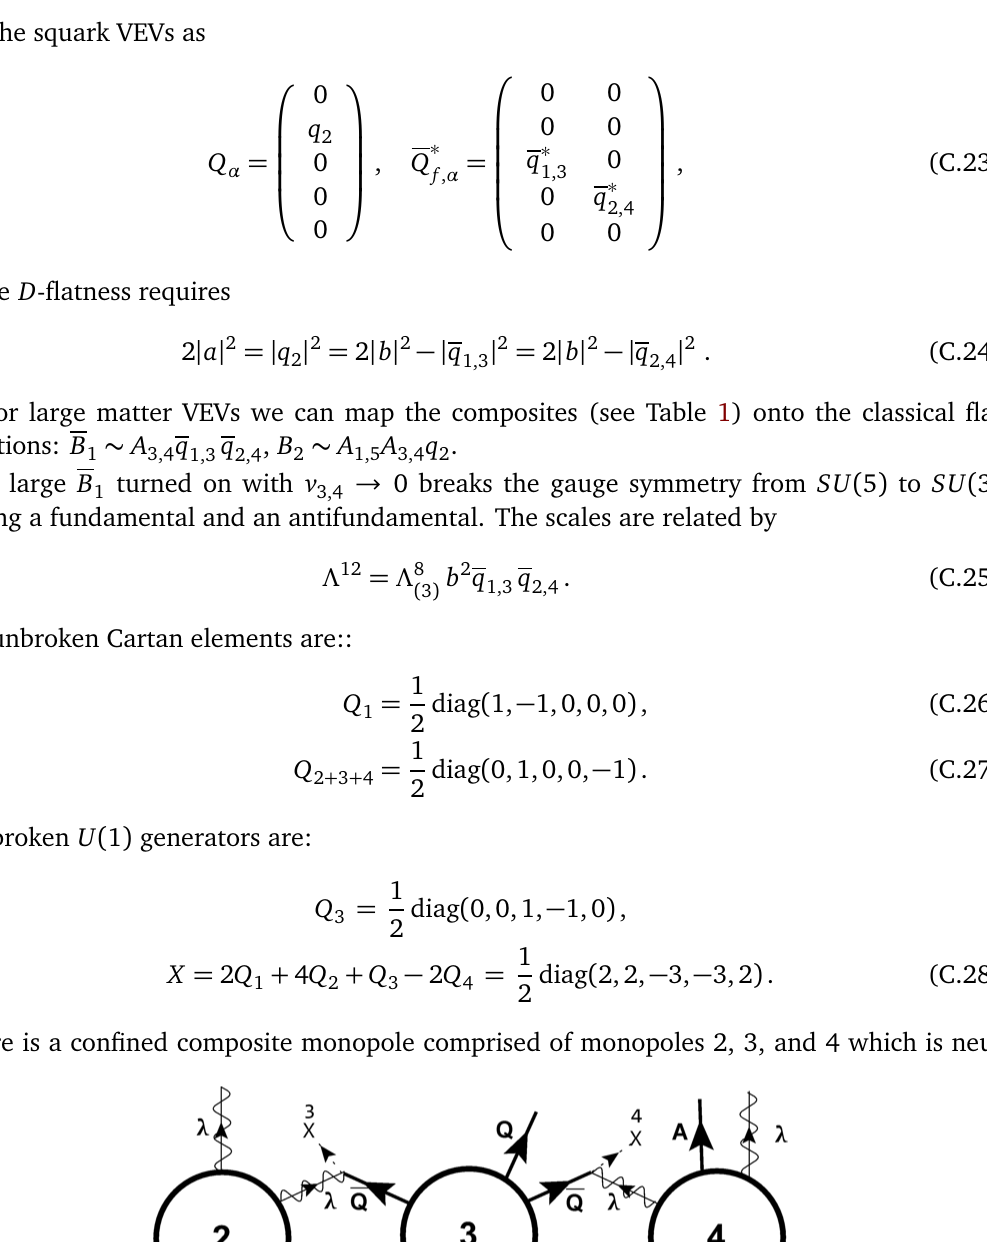
Figure 15: A sketch of the multi-monopole composite with + + 2 when B large. The gauge group breaks to SU ( 3 ) . The antisymmetric and squark VEVs, (C.22) and (C.23), are represented as a cross with their color